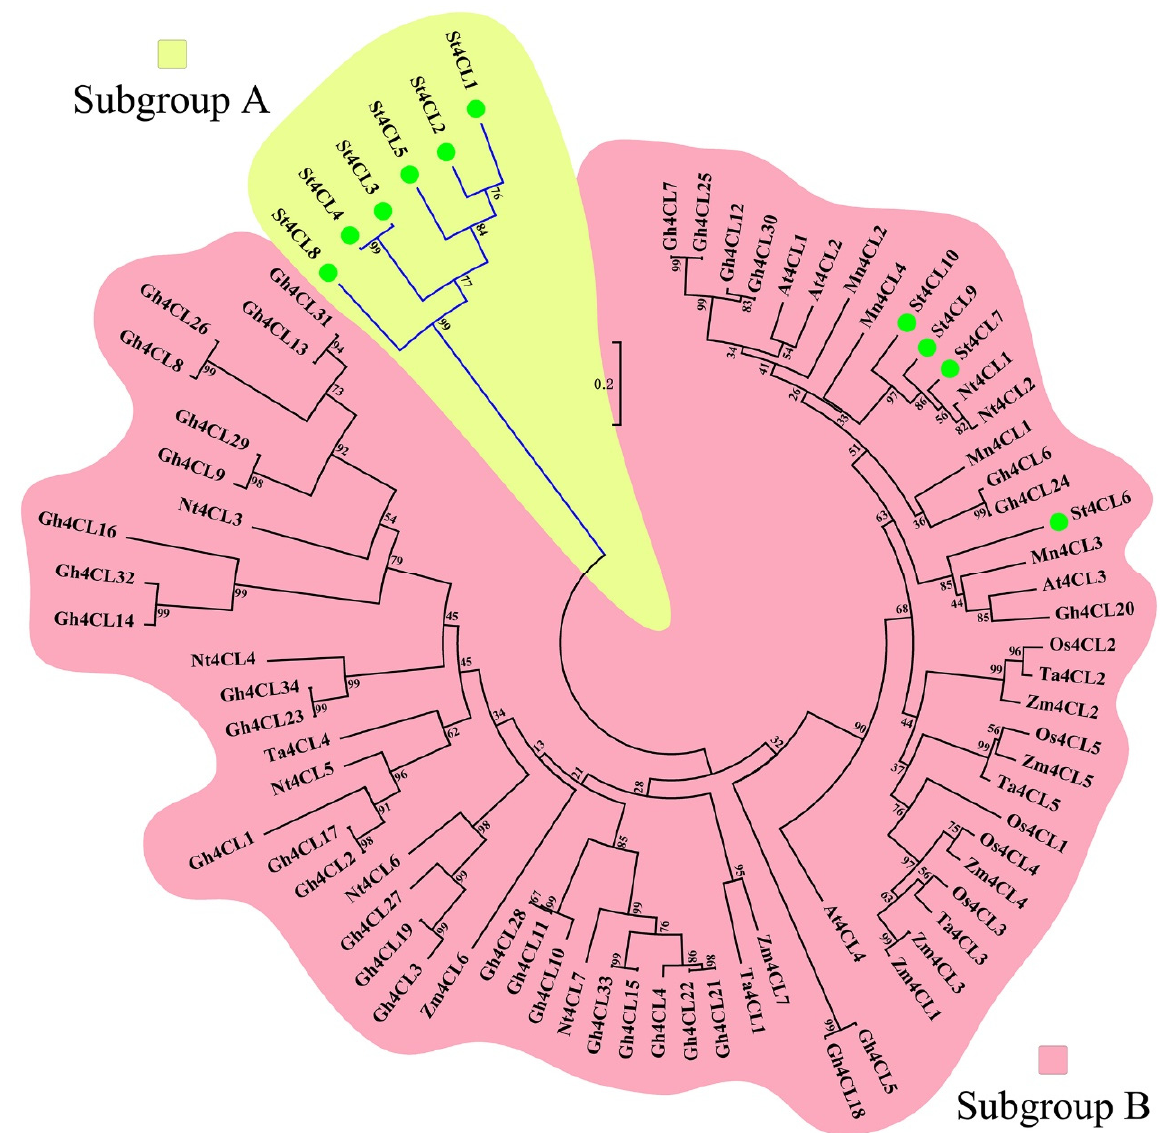
Figure 2. Phylogenetic analysis of 4CL genes in plants. Phylogenetic analysis was performed by the neighbor-joining (NJ) method using MEGA10 software with a bootstrap test of 1000 replicates. The Yellow region is the branch that subgroup A contains, and the pink region is the branch that subgroup B contains.